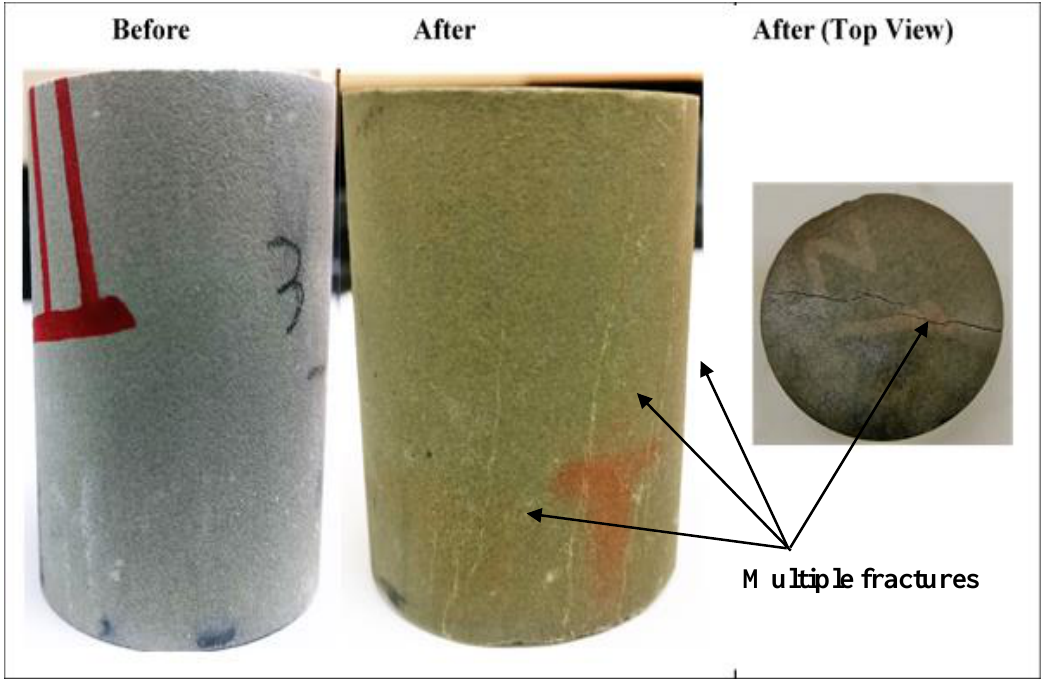
Figure 6. Pressure profiles for a pure thermochemical fluid (TCF) and TCF-condensate system.